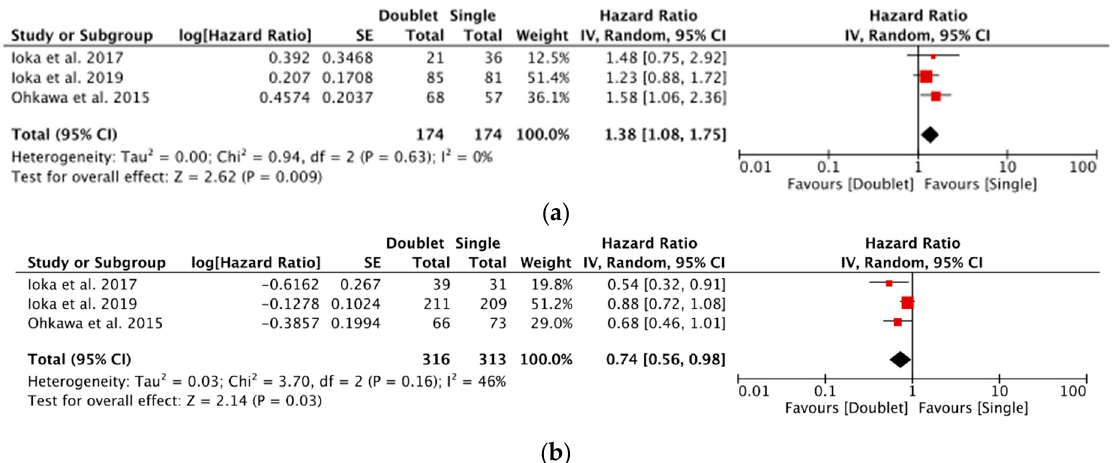
Figure 3. ( a ) Forest plot showing meta-analysis of overall survival in elderly patients for second-line studies [4,18,19] and ( b ) Forest plot showing meta-analysis of overall survival in young patients for second-line studies [4,18,19]. Table 3. Subgroup analysis of elderly patient outcomes including OS, PFS, and ORR along with 95% con fi dence intervals where provided.